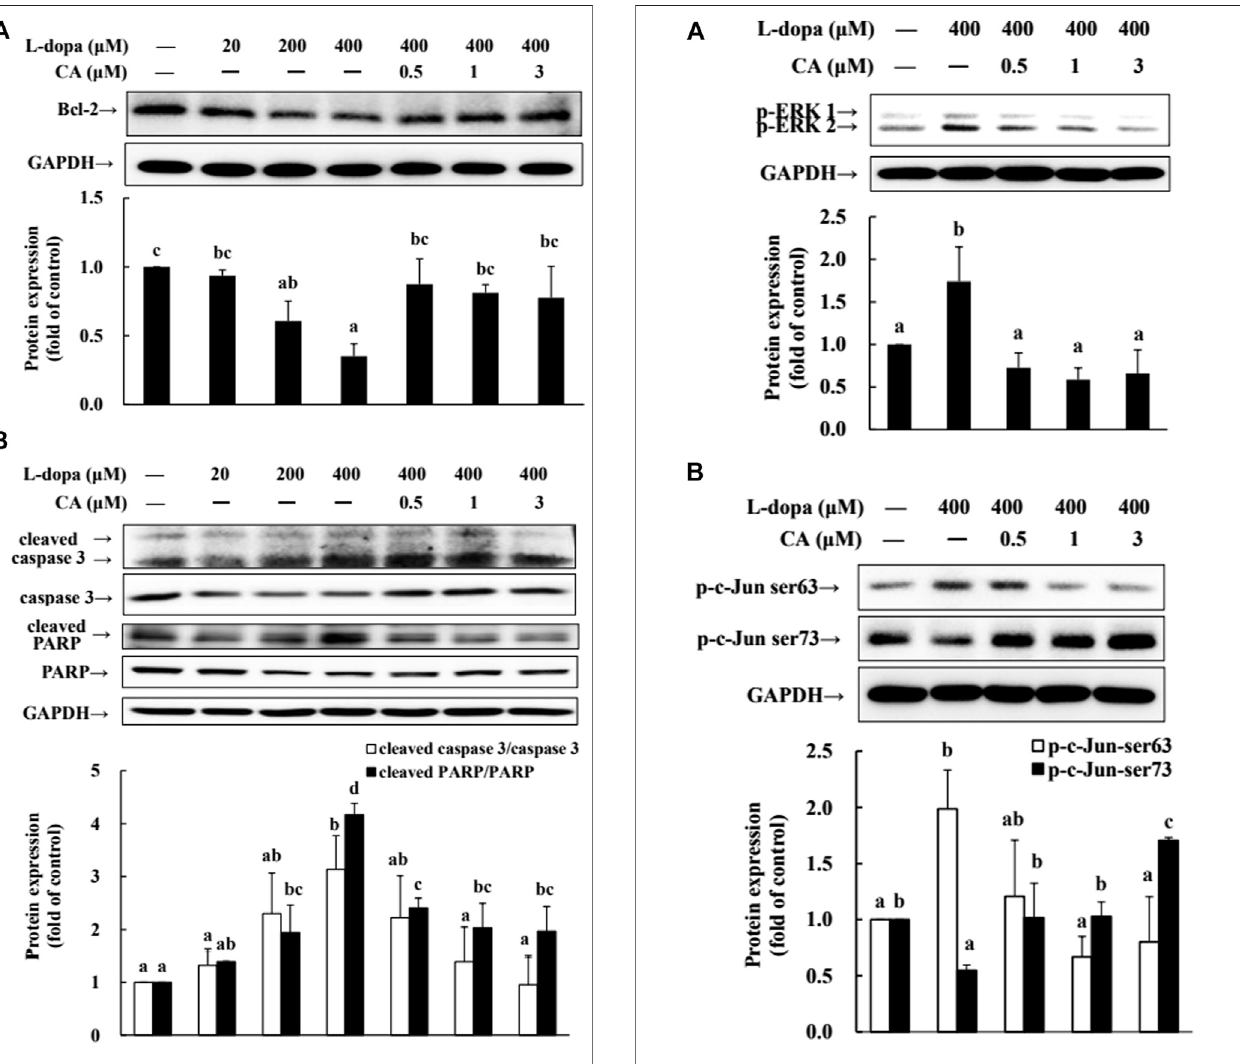
FIGURE6| Involvementofreduction inapoptosis-related proteins inthe neuroprotective effects of CA. (A) Cells were pretreated with DMSO alone ( − ) or0.5,1,or3 μ MCAfor18handwerethentreatedwith20,200,and400 μ M L -dopa for an additional 24 h. One representative immunoblot out of threeindependentexperimentsisshown. (B) Thecontrolgroupwasregarded as 1. Values are mean ± SD ( n (cid:1) 3). Means not sharing a common letter are signi fi cantly different, p < 0.05.